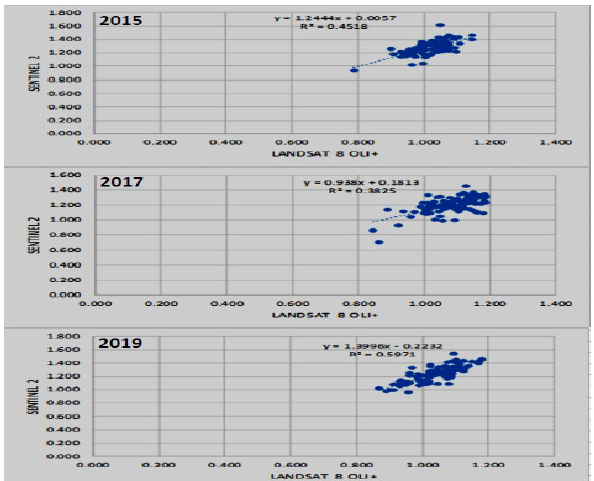
Figure 3: Scatter Plots for GCI Relationship in Landsat 8 OLI and Sentinel 2A